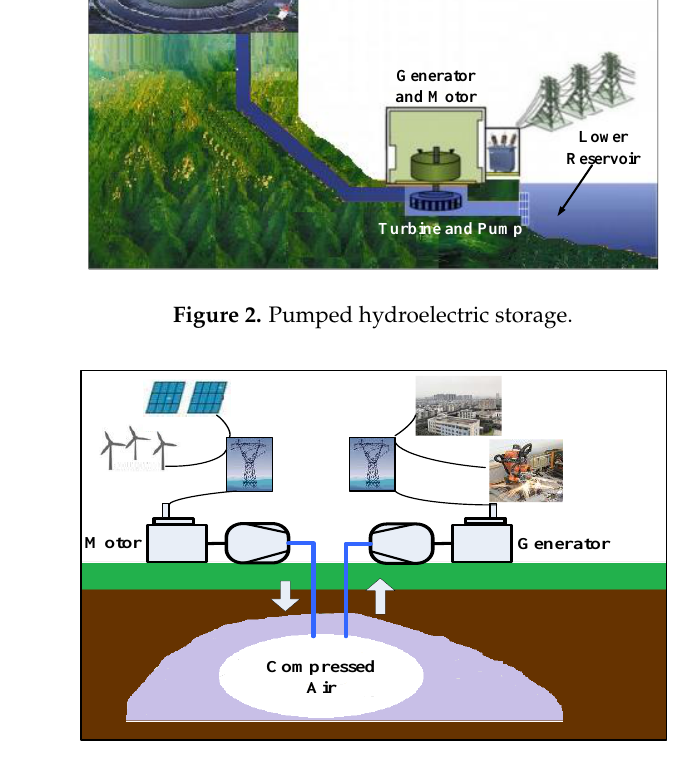
Figure 3. Illustration of a compressed air energy storage process.